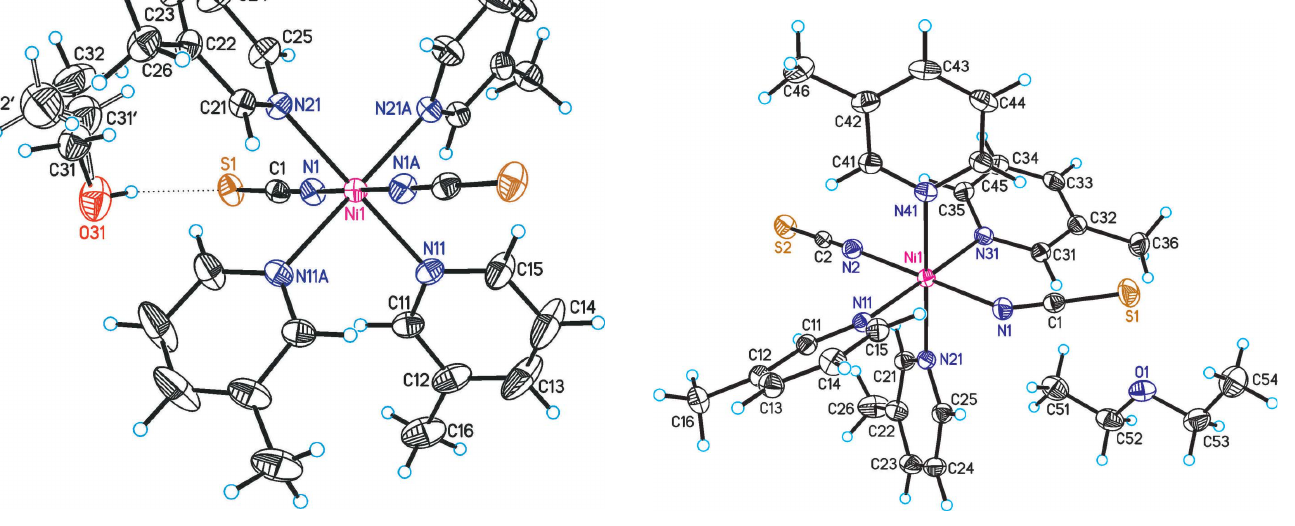
Figure 3 The molecular structure of compound 3 with labeling and displacement ellipsoids drawn at the 50% probability level.